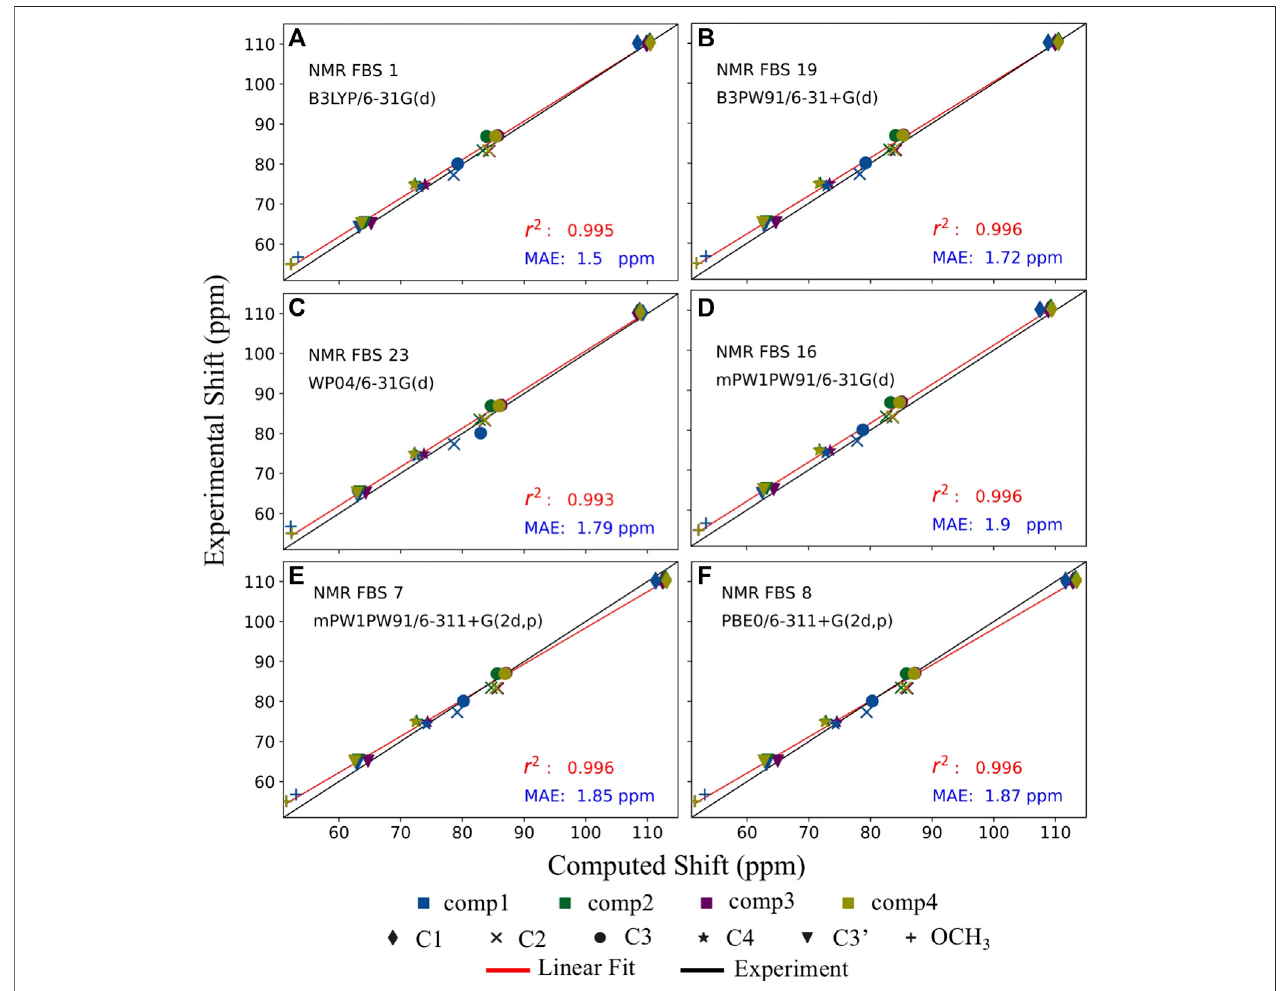
FIGURE 7 | Balancing accuracy with precision. Comparison of the top 6 performing nuclear magnetic resonance (NMR) functional – basis sets (FBS): 1 (A) , 19 (B) , 23 (C) ,16 (D) ,7 (E) ,and8 (F) .Implicitsolvationwasmodeledforbothgeometryoptimizationsandshieldingconstantcalculations.Eachofthesixcarbonsisdenotedby a different shape, while each of the four compounds is denoted by a different color. The black line represents the literature values for the experimental chemical shifts, whereas the red line represents the best- fi t line for the computed chemical shifts used to extract the r 2 values.